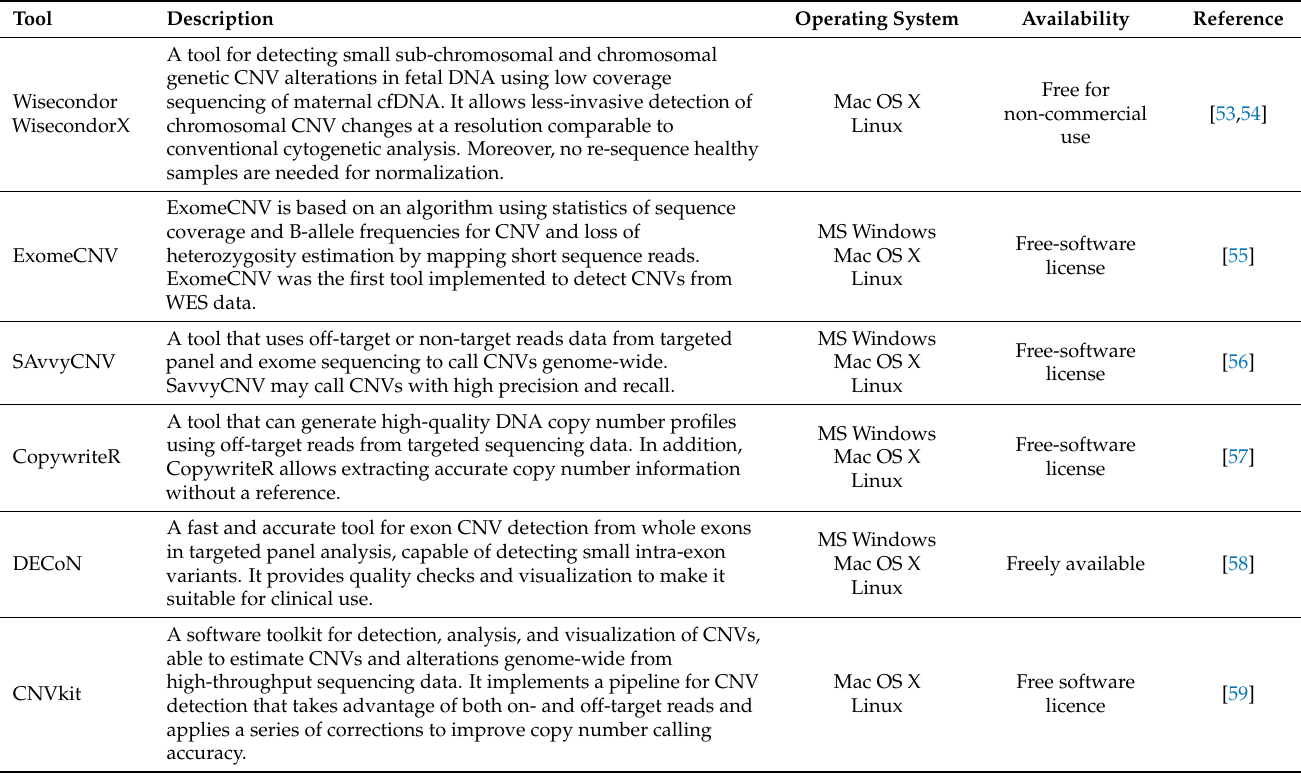
Table 1. Bioinformatic tools for detection of CNVs from next generation sequencing-based genomic data. Several tools are capable of detection and annotation of CNVs at the same time (e.g., iCopyDAV, SG-ADVISER-CNV, DeAnnCNV), so they are listed in the next table. WES (whole-exome sequencing); WGS (whole-genome